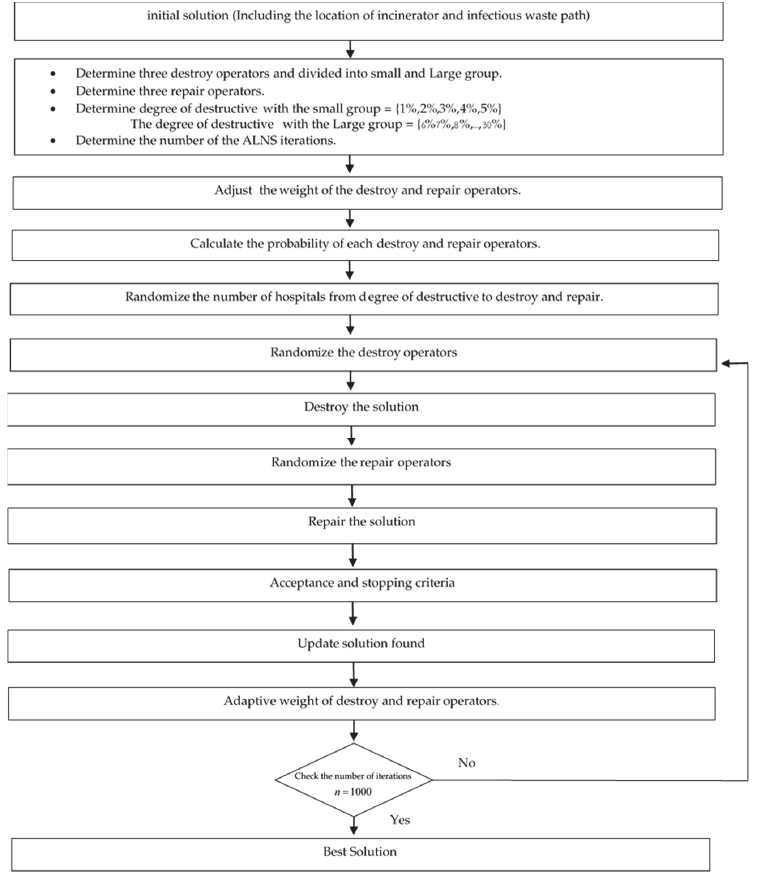
Fig. 3 . The steps of the ALNS